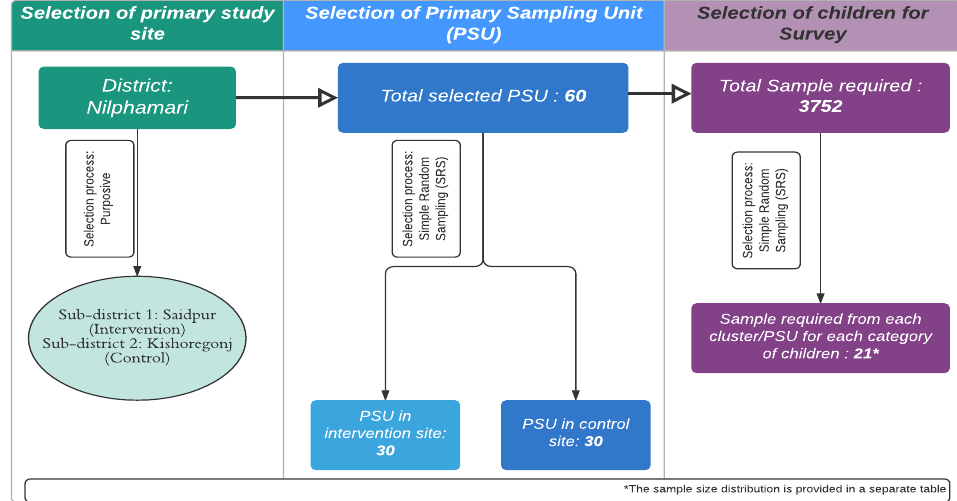
Figure 1. Sampling procedure followed for the selection of samples.